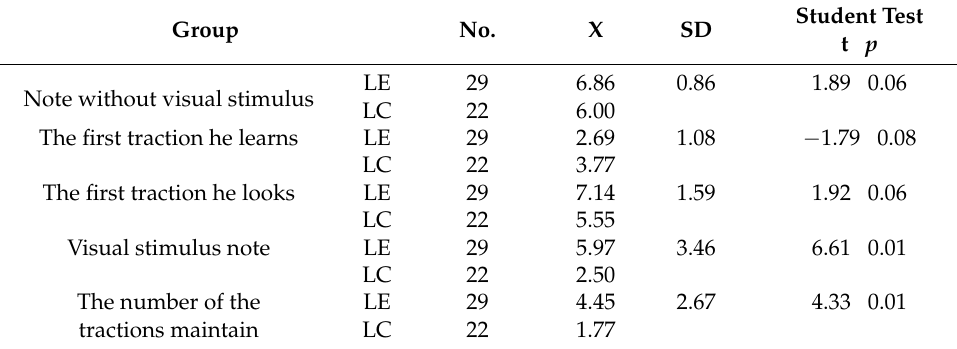
Table 1. Statistical description of the research activity